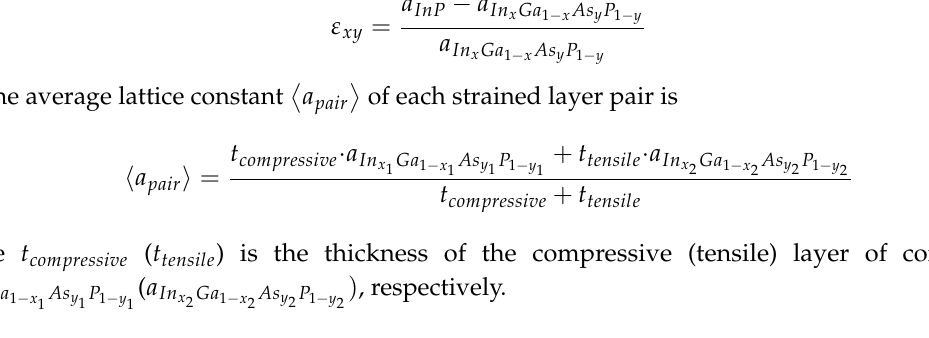
Figure 5. RSM map of ( a ) 1% compressive and ( b ) 1% tensile strained InGaAsP layer on bulk InP.